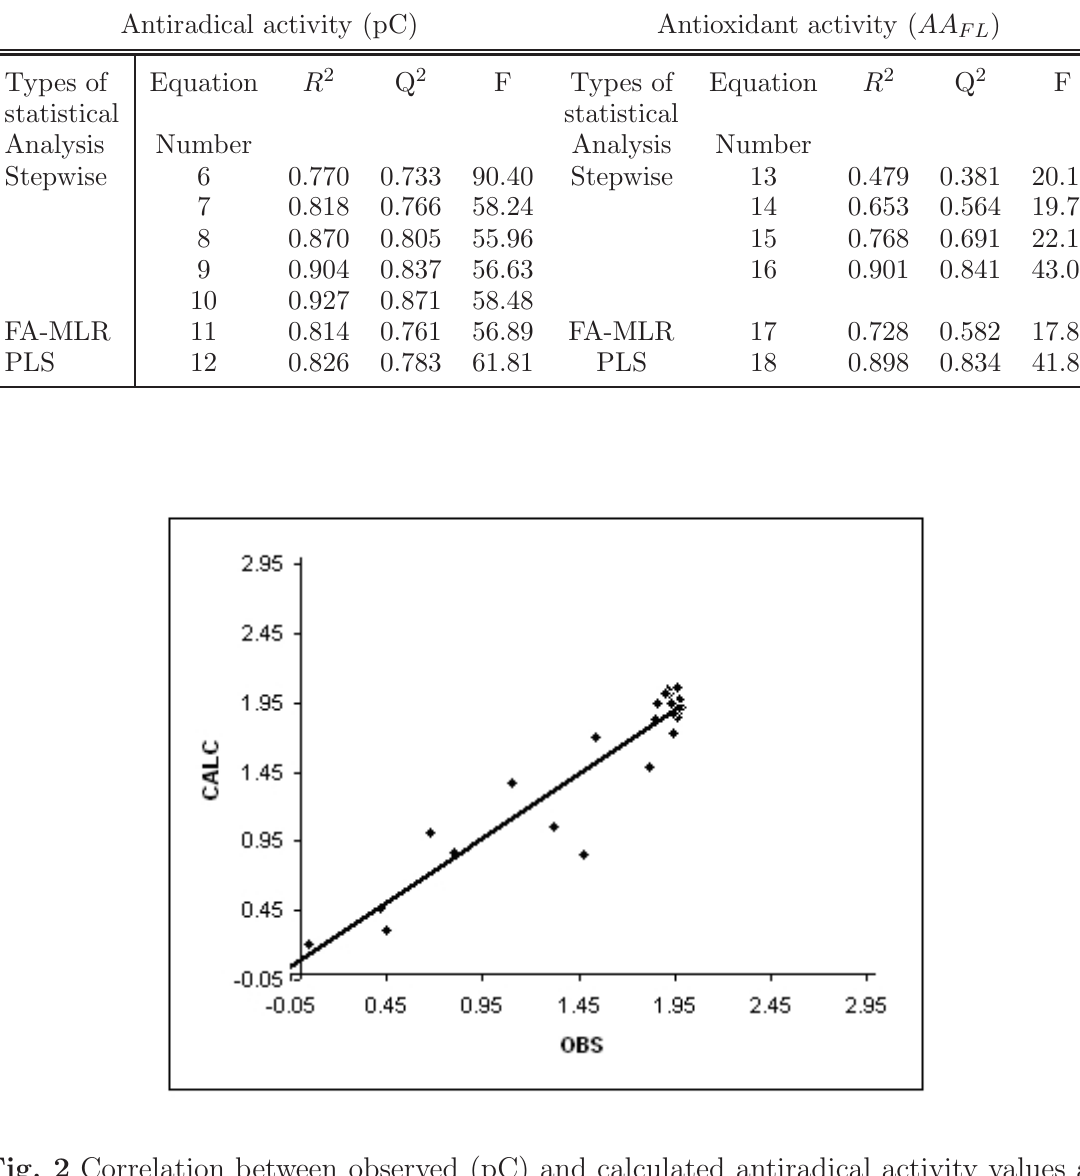
Fig. 2 Correlation between observed (pC) and calculated antiradical activity values ac- cording to Eq.